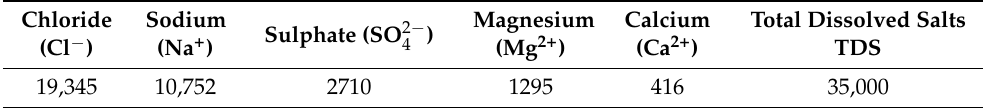
Table 1. Seawater main composition (ppm)